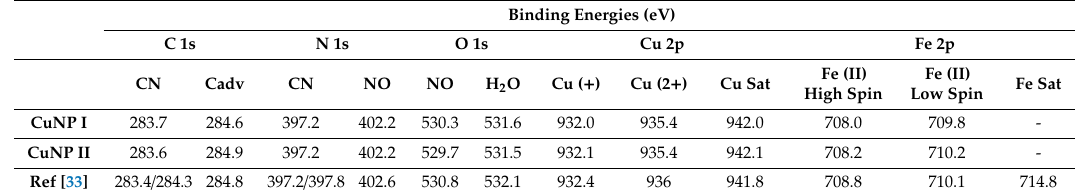
Table 2. XPS quantification (normalized areas) of sample I and II. The value of N (NO) was set to